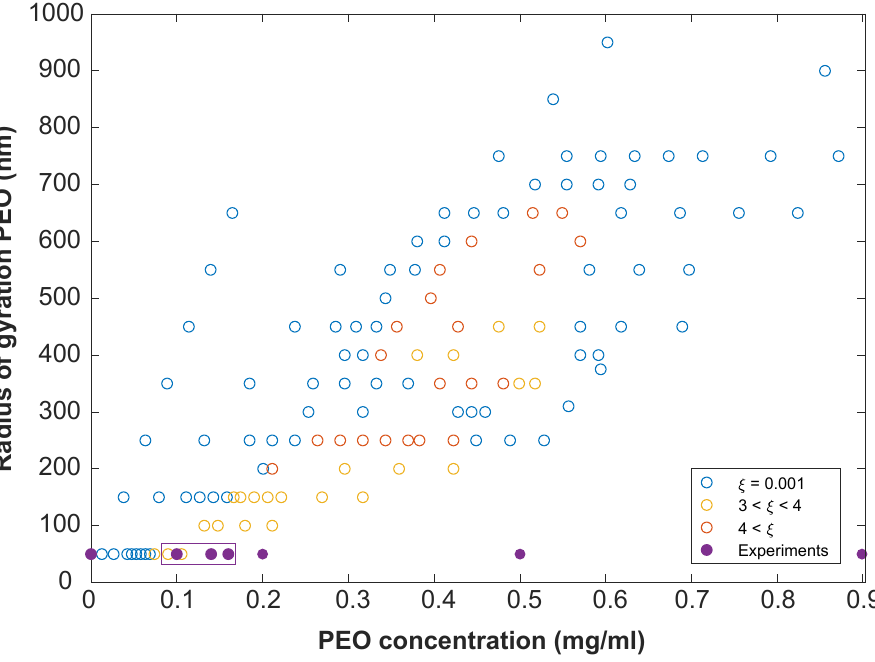
sphere chains, Figure S4: superparamagnetic silica spheres, Table S1: properties of the three pairs of Helmholtz coils, Video S1: formation of linear chains in a magnetic field of 3mT (video is sped up, total duration: 1 h), Video S2: chiral chain of magnetic spheres in magnetic field of 1.4mT, Video S3: long chiral chain of magnetic spheres in magnetic field of 1.4mT, Video S4: chiral chain falling apart upon turning off the magnetic